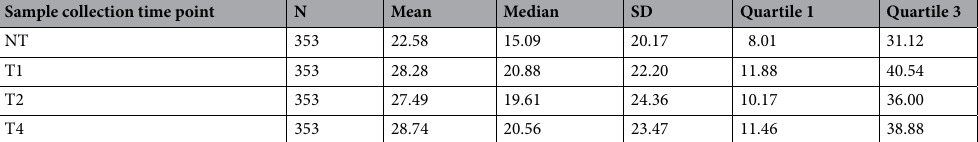
Table 2. Distribution of interindividual variability of metabolite abundance of the 353 metabolites, measured as the Coefficient of Variations (CVs) by collection time points [T1, T2, T4: 1, 2 and 4 min, respectively, after tying the tourniquet and NT (no tourniquet with collection 5 min after removal of the tourniquet)] in 05 study participants. The CVs were calculated as the ratio of median absolute deviation about median to median of the unscaled abundance (peak intensities) of respective metabolites. T1, T2, T4 are 1, 2 and 4 min respectively, of time elapsed after tying the tourniquet; NT is no tourniquet, where blood sample collection occurred 5 min after removal of the